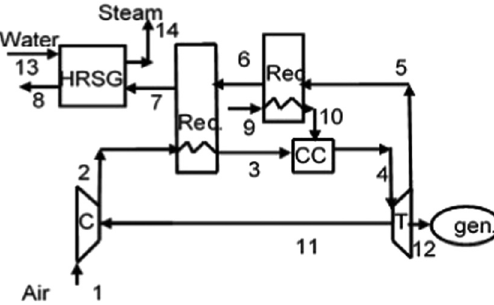
Figure 3: Diagram of an airfh cogeneration cycle.